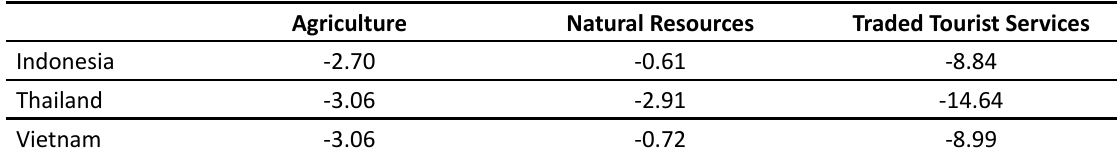
Table 1: Output Implications of Amplified Global Pandemic–Cumulative Impacts (% Devia - tions from The Benchmark) Agriculture Natural Resources Traded Tourist